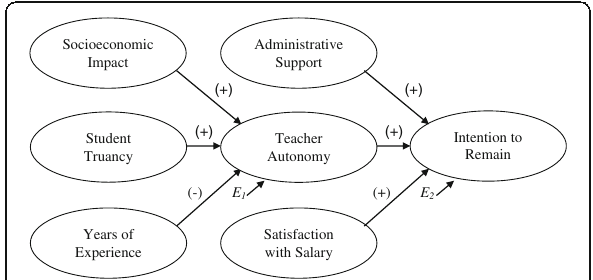
Fig. 1 Model of hypothetical relationships in the